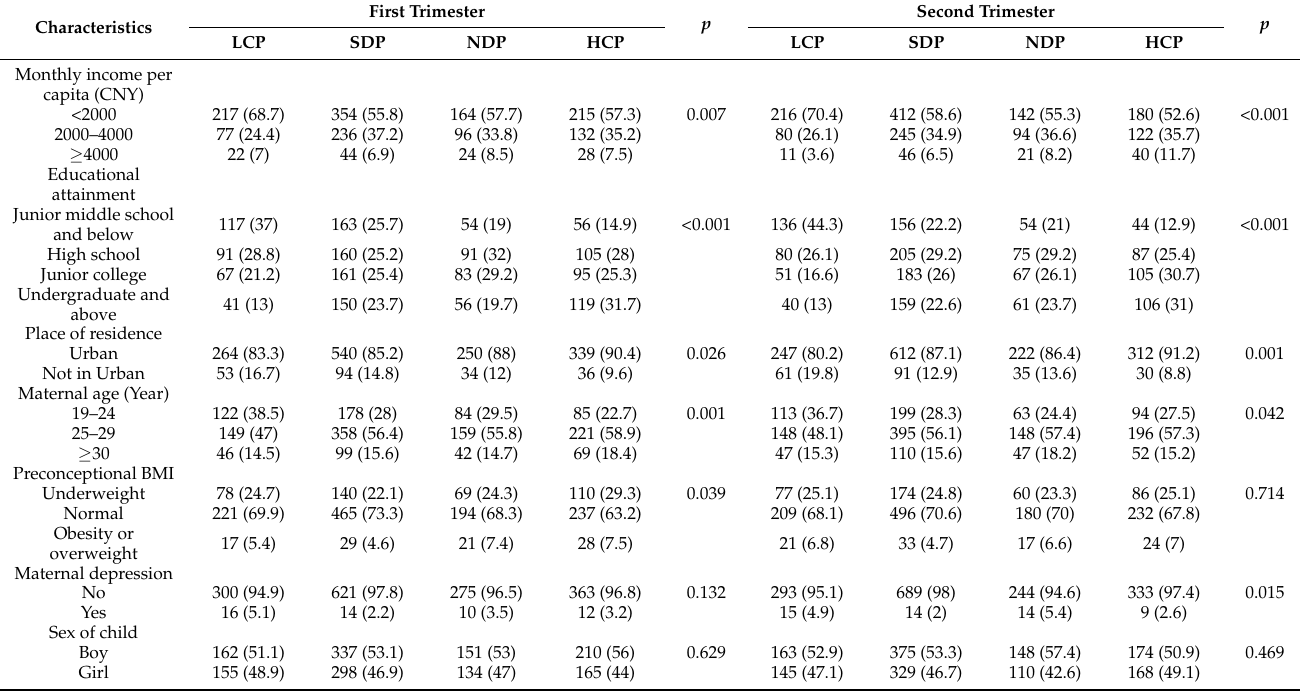
Table 5. Distribution of sociodemographic characteristics by prenatal maternal dietary patterns.